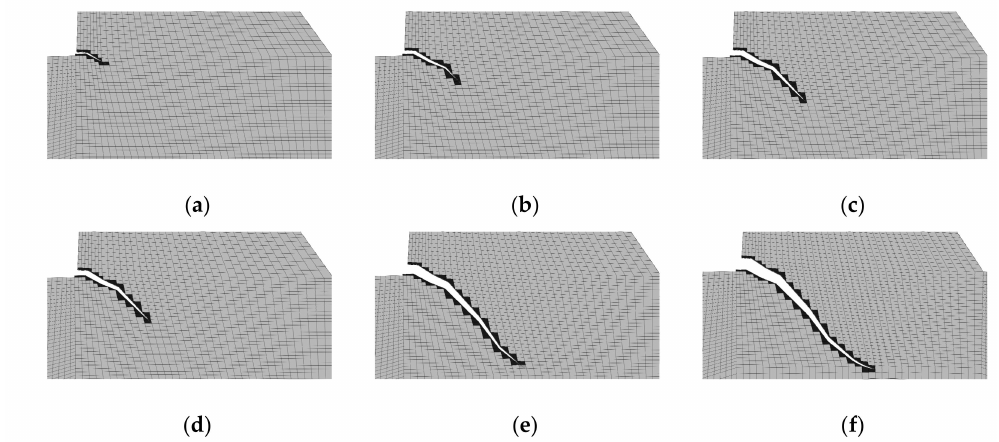
Figure 19. Interlayer joint propagation located at the dam heel (magnified by 1000 times): ( a ) 39 step; ( b ) 110 step; ( c ) 211 step; ( d ) 370 incremental step; ( e ) 211 step and ( f ) 370 incremental